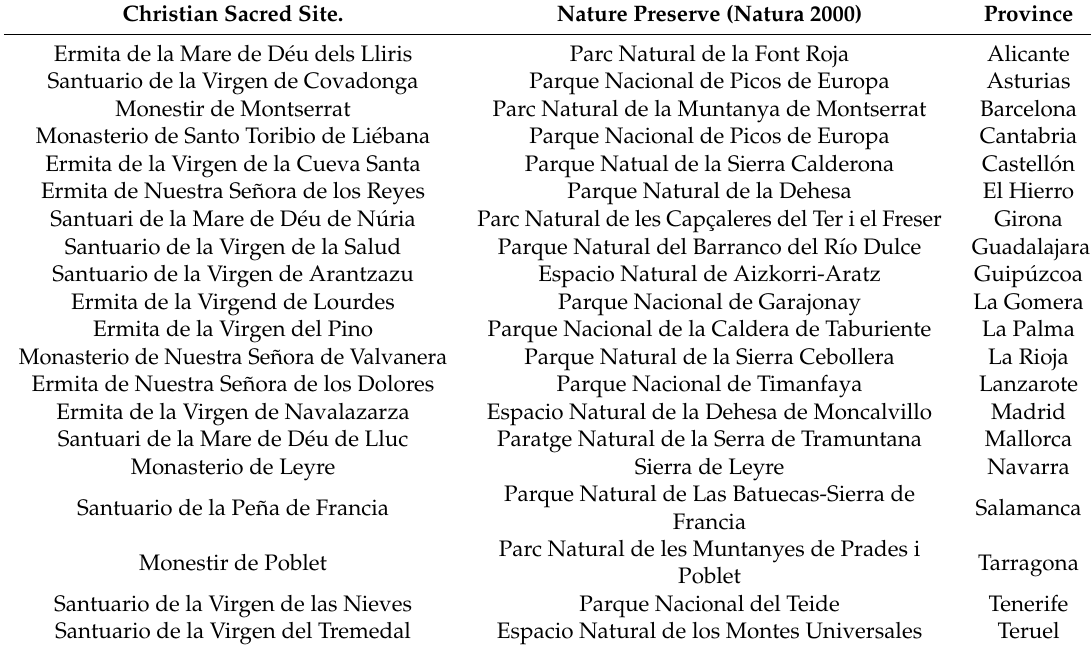
Table 1. Popular Spanish Marian sanctuaries with long-established custodians within Natura 2000. Christian Sacred